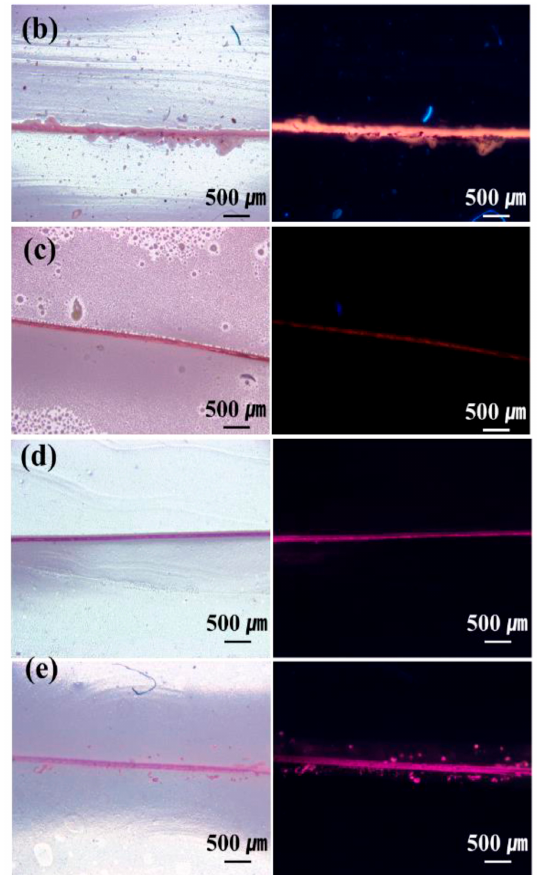
Figure 5. Optical micrographs of scratched regions in the comparison coatings and self-healing coatings under white light and UV light (a fluorescent fluid was mixed in the cores to visualize the release of the core materials upon microcapsule rupture); ( a ) n -Hexadecane-based comparison coating observed at − 20 to − 17 °C; ( b ) n -hexadecane-based comparison coating at room temperature (23 °C); ( c ) STP-based coating at − 20 to − 17 °C; ( d ) DD-based coating at − 20 to − 17 °C; and ( e ) STP and DD-based self-healing coating at − 20 to − 17 °C.